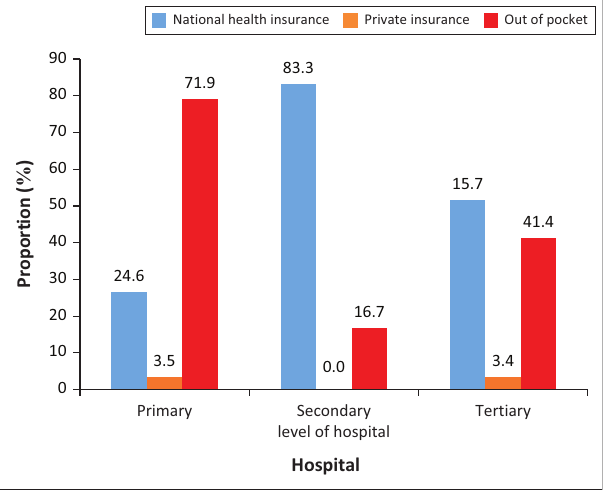
FIGURE 3: Rehabilitation payment system available at the primary-, secondary- and tertiary-level hospitals.